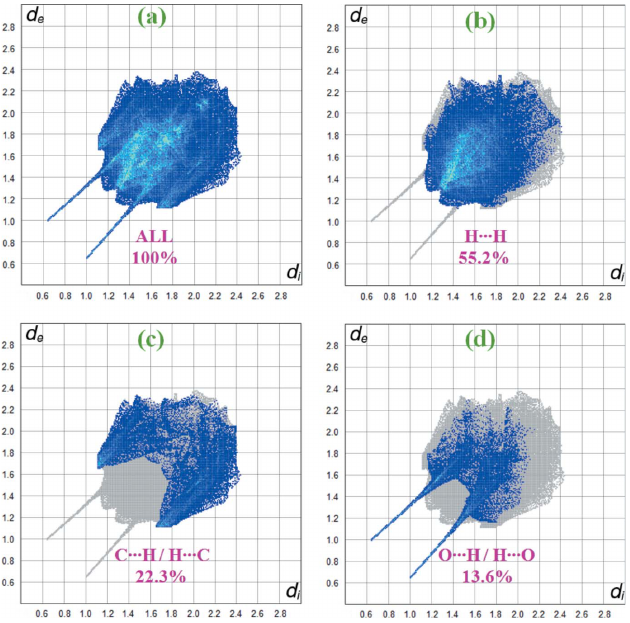
Figure 5 Two-dimensional fingerprint plots for the title compound giving the relative contribution of atom pairs to the Hirshfeld surface.